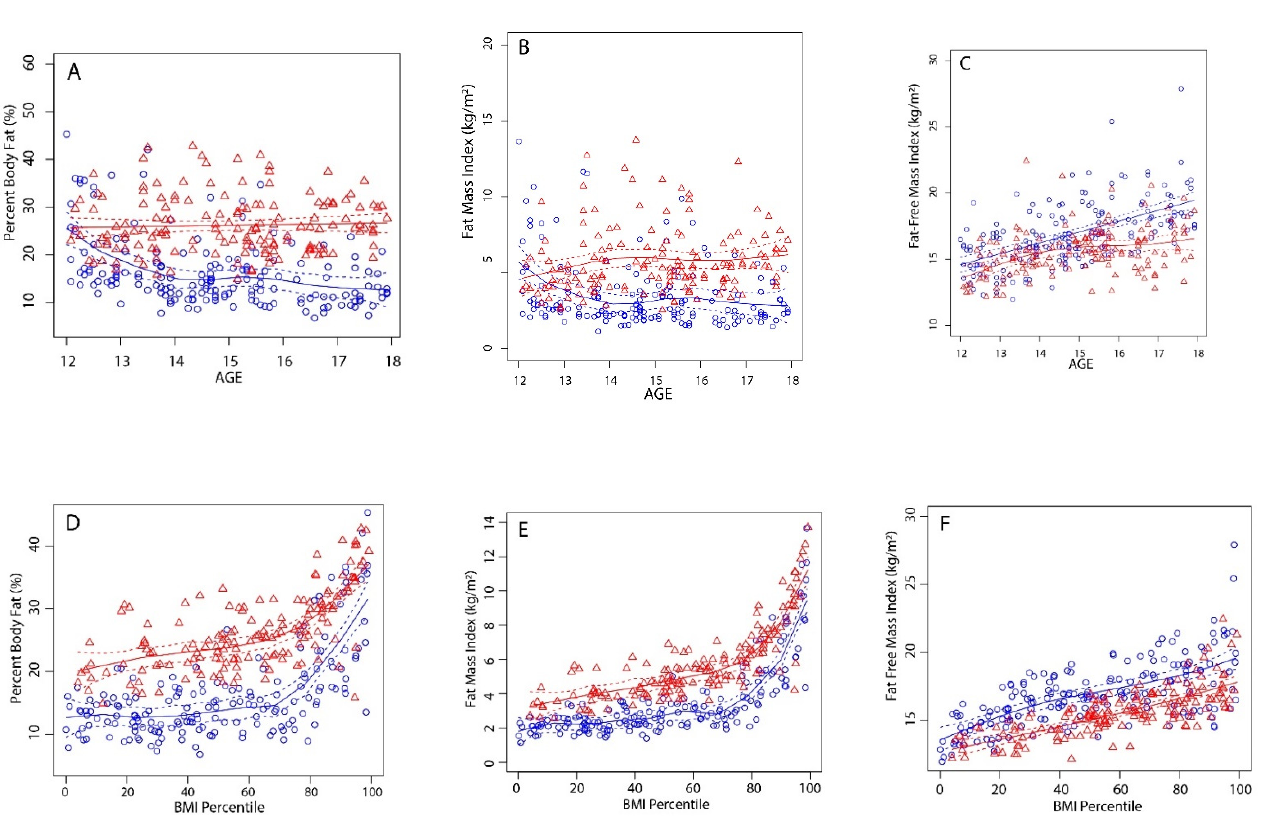
Figure 1. Cross-sectional trends in ( A ) body fat percentage, ( B ) fat mass index, and ( C ) fat-free mass index by age, and the relationship between BMI percentile rank and ( D ) body fat percentage, ( E ) fat mass index, and ( F ) fat-free mass index. Blue markers and lines = boys; red markers and lines = girls; lines of best fit are solid; 95% confidence intervals are dashed lines. Lines of best fit with nonoverlapping 95% confidence intervals conservatively demonstrate statistical difference ( p = 0.05).